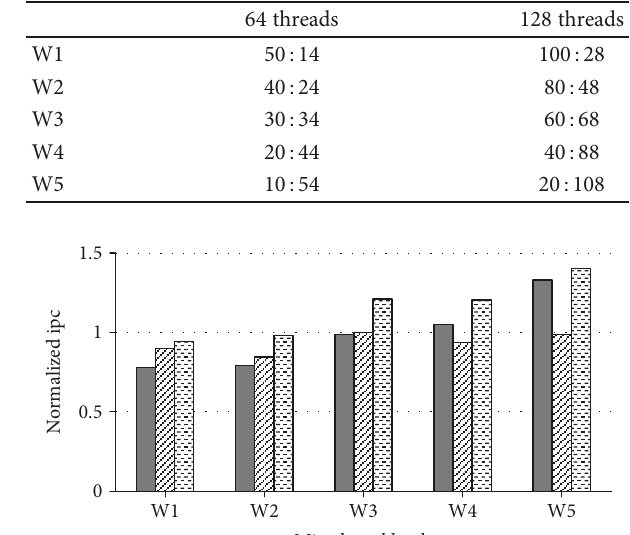
Table 3: Mixed nonlatency-sensitive and latency-sensitive loads.